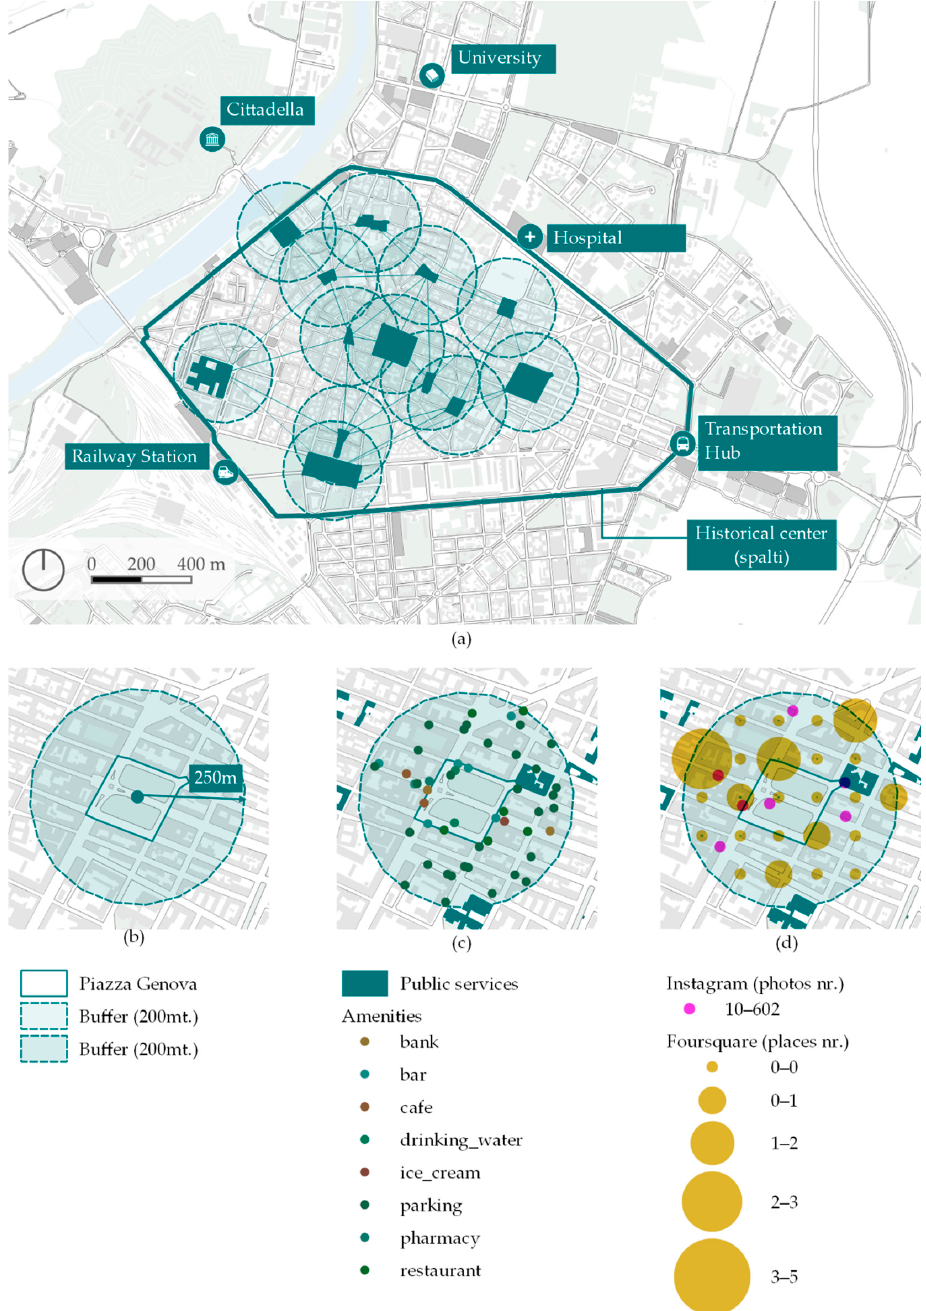
Figure 5. ( a ) For each of the selected squares, a buffer has been created, ( b ) calculated using a 250 m radius from the centroid of the perimetral polygon, as shown in detail in the example of Piazza Genova/Matteotti; ( c ) this geometry has been used as a basis for collecting data related to the square and its area of influence, such as amenities and public services marked in the picture; ( d ) and for revealing its use through social media datasets; for instance, in the picture, the magenta dots are the Instagram places (sized by a number of photos), the yellow ones are the concentration of Flickr photos, whereas the green ones are the concentration of Foursquare places [Sources: Authors, Open- StreetMap, Municipality of Alessandria].